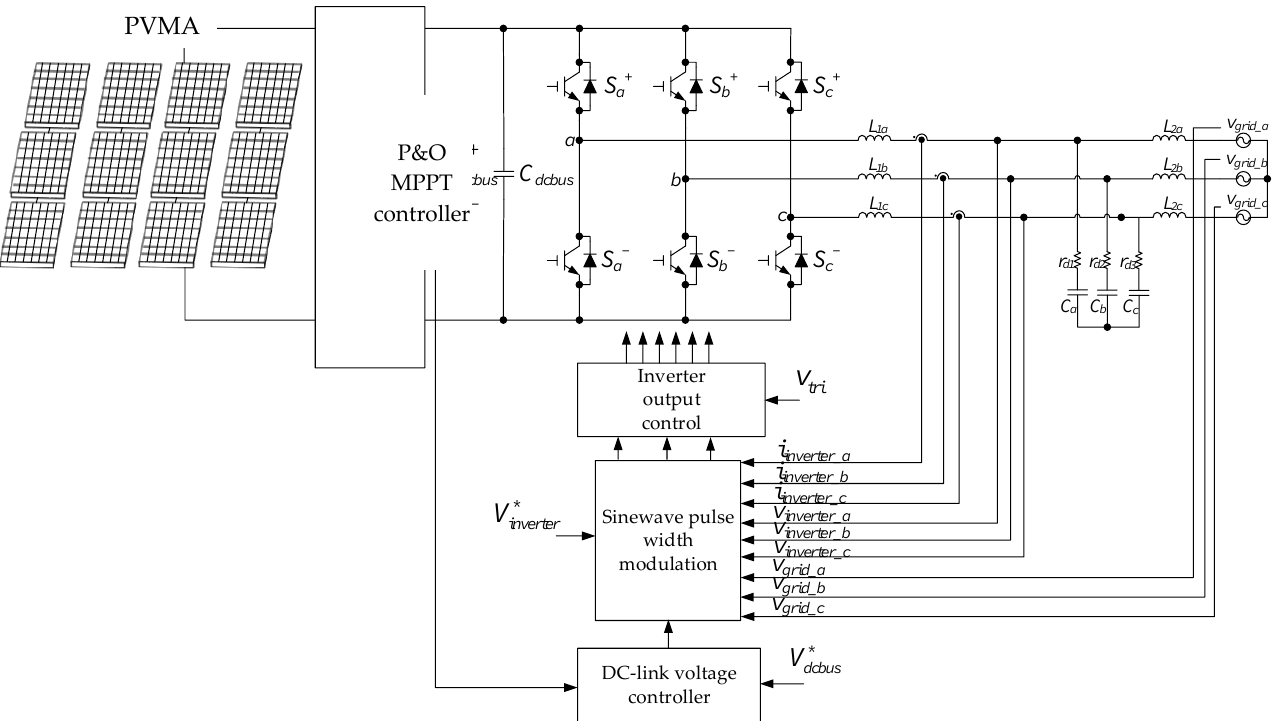
Figure 4. Circuit architecture of three-phase photovoltaic full-bridge inverter.